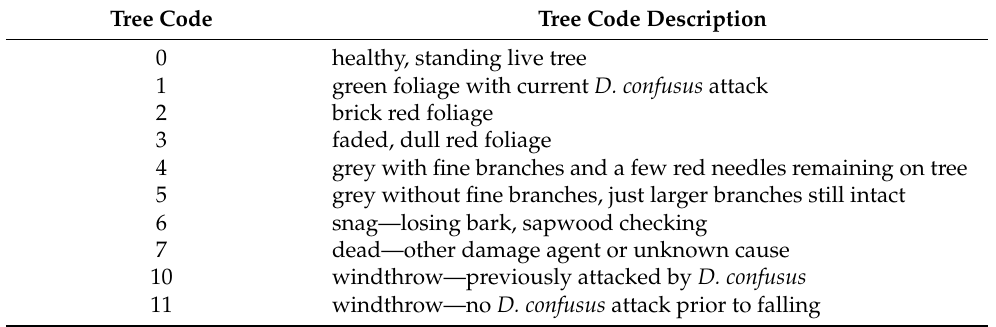
Table 2. Tree codes for describing subalpine fir trees are listed. Tree codes 1–6 and 10 indicate subalpine fir attacked and killed by D. confusus . Tree codes 7 and 11 indicate mortality due to other pests or unknown